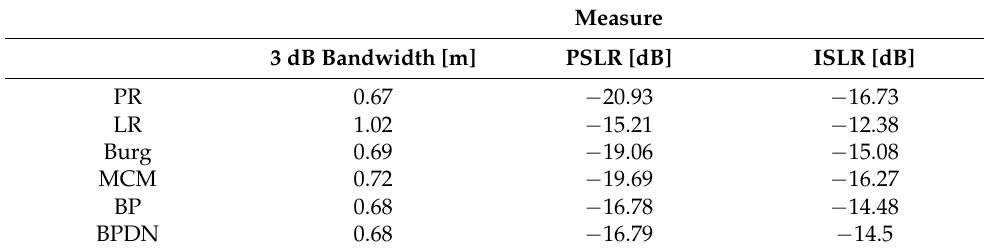
Table 1. Comparison of three quality parameters of slant-range cuts.